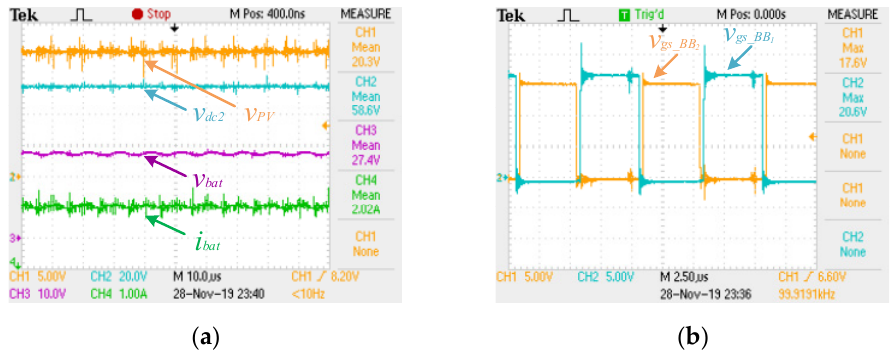
Figure 7. PV2B operation mode: ( a ) voltage on the solar PV panels (CH1: 5 V/div), secondary dc-link (CH2: 20 V/div) and BESS (CH3: 10 V/div) and current at the BESS (CH4: 1 A/div); ( b ) gate-source voltage in each of the semiconductors that make up the back-end bidirectional dc–dc buck–boost converter (CH1: 5 V/div), (CH2: 5 V/div).